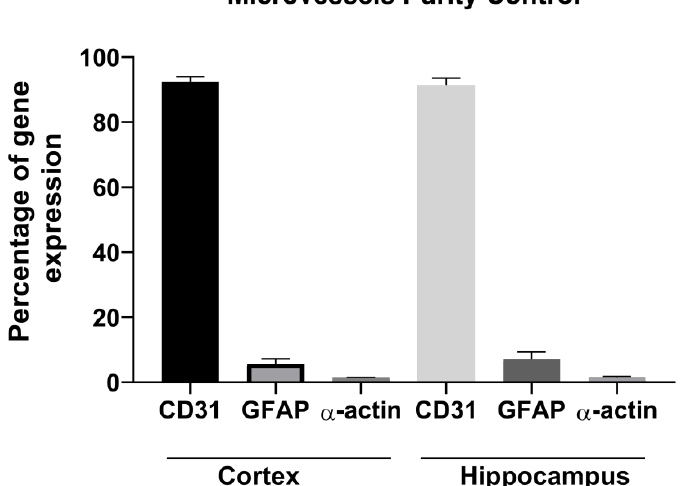
Figure 2. The purity of the mice brain endothelial micro vessels isolated from the cortex and the hippocampus. mRNA levels of CD3, Glial fibrillary acid, and α-actin were measured through real- time PCR. Results are the means ± SEM from three lots of brain endothelial micro vessels (each lot represents a pool from five mice) and PCR performed in duplicate for each single preparation.